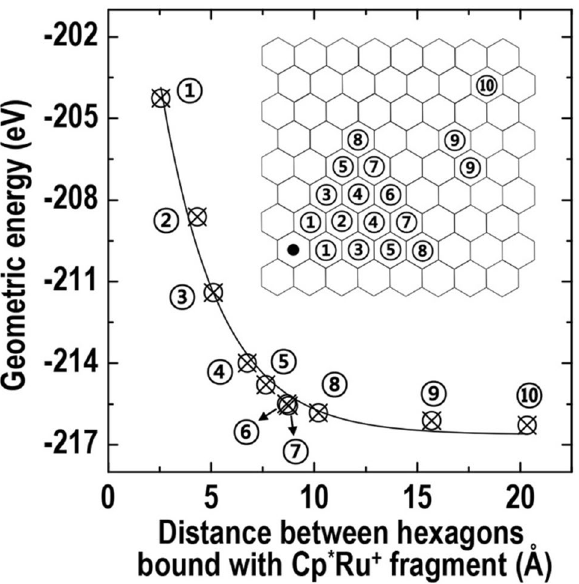
Figure 4. Simulated geometric energies of Cp * Ru + -graphene anchored with two fragments as a function of distance between hexagons bound with the